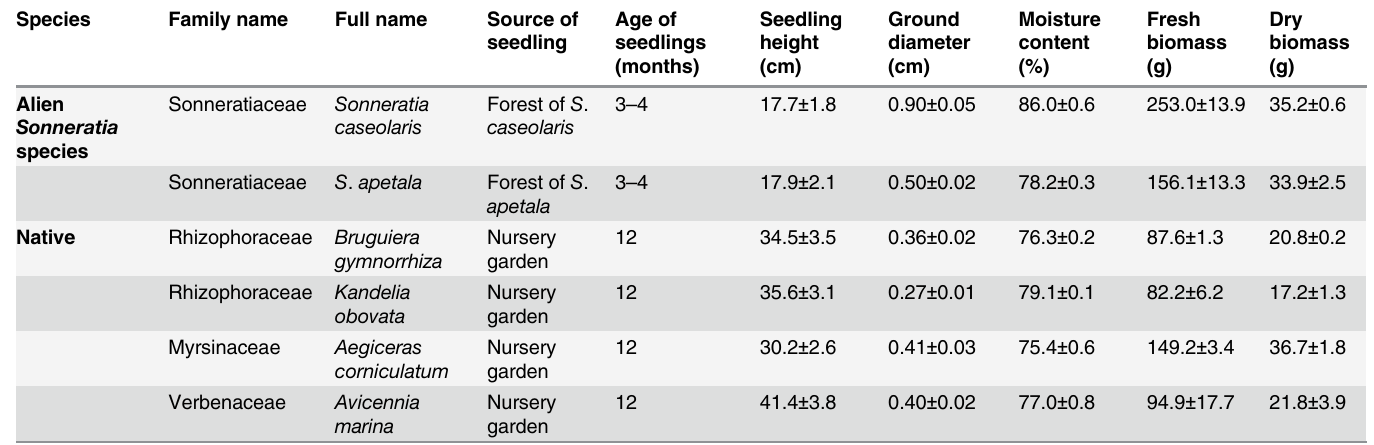
Table 1. Information on mangrove seedlings transplanted to pots on 12 th July,